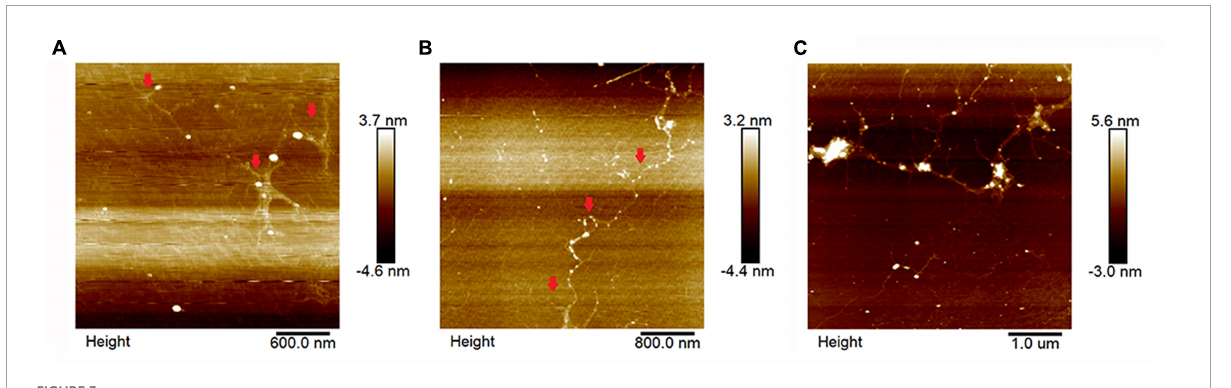
FIGURE3 AFM imaging of HWp (A) , HAp (B) , and HALp (C) .